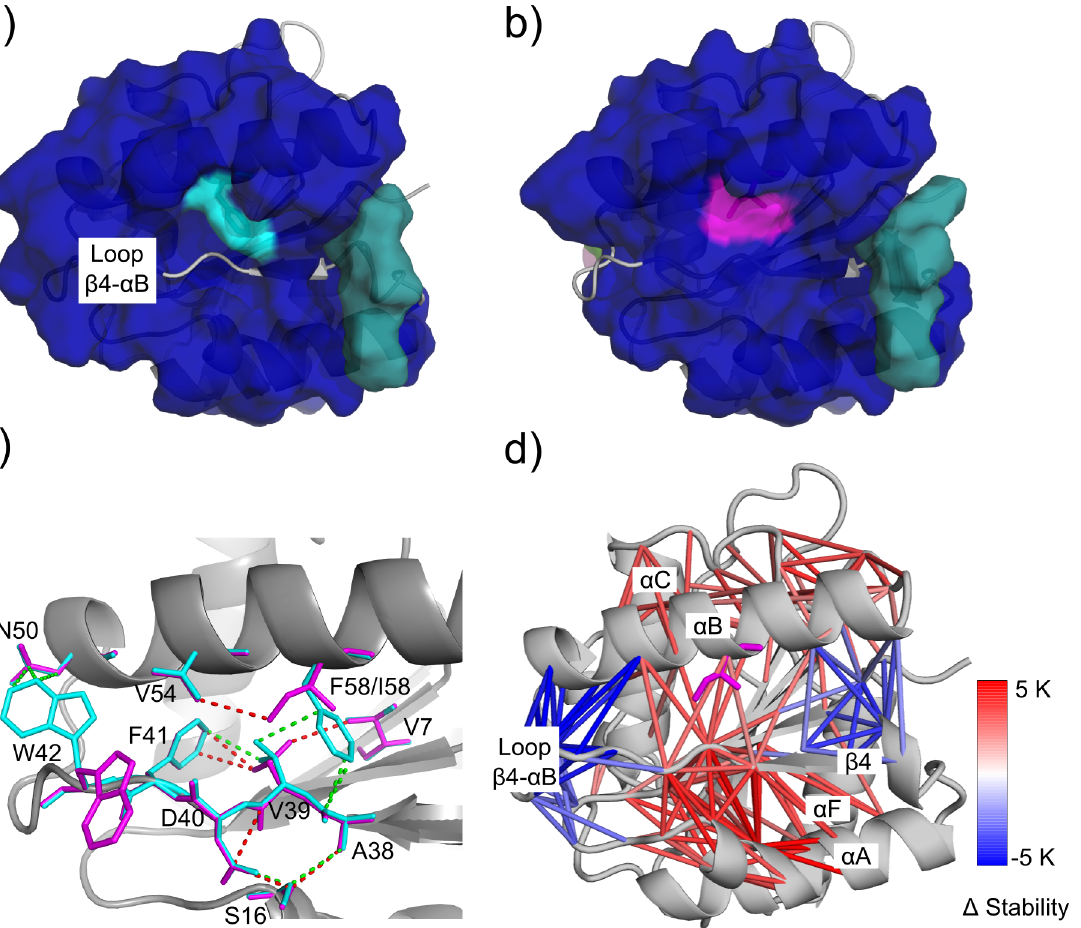
Fig 4. Structural origin of differences in the thermostability of WT and F58I, shown by a rigid cluster decomposition of WT (a) and F58I (b) at 316 K. Rigid clusters are shown as uniformly colored bodies. The mutation site (residue 58), shown by a cyan (a) and a magenta (b) surface, is part of the largest rigid cluster (blue) in both WT and F58I. Hydrophobic contacts in the proximity of the mutation site between carbon atom pairs at most 3.8 Å apart are shown as green (WT) and red (F58I) dashed lines (c). Residues involved in making such contacts are shown as cyan (WT) and magenta (F58I) sticks. Differences in the stability of “ rigid contacts ” between variant F58I and WT are depicted on the variant structure (d). Two residues form a “ rigid contact ” if they belong to one rigid cluster. A red (blue) stick connecting C α atoms of two residues indicates that a rigid contact in the variant is more (less) stable than in the WT (see color scale). Only those contacts of variant F58I that are stabilized or destabilized by (cid:1) 2 K are shown for clarity; for the same reason, contacts between two residues of the same secondary structure element are not shown. The mutated residue I58 is displayed by magenta sticks. Blow-ups of panel d showing the contact stability between secondary structure pairs mentioned in the main text can be found in S5